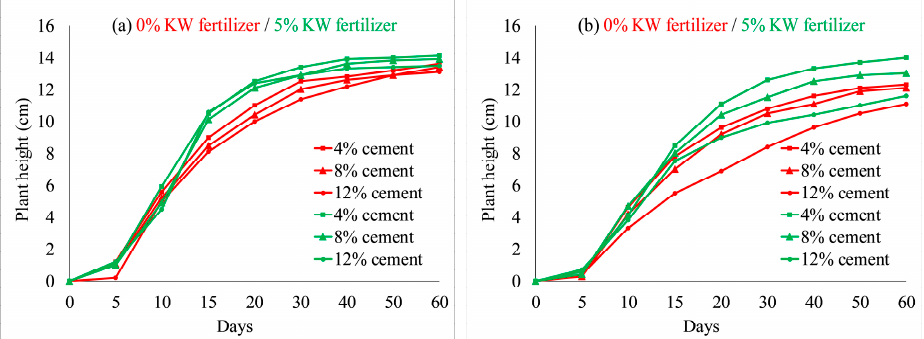
Figure 7. Plant heights related to different percentages of cement: ( a ) Ryegrass ; ( b ) Festuca elata .